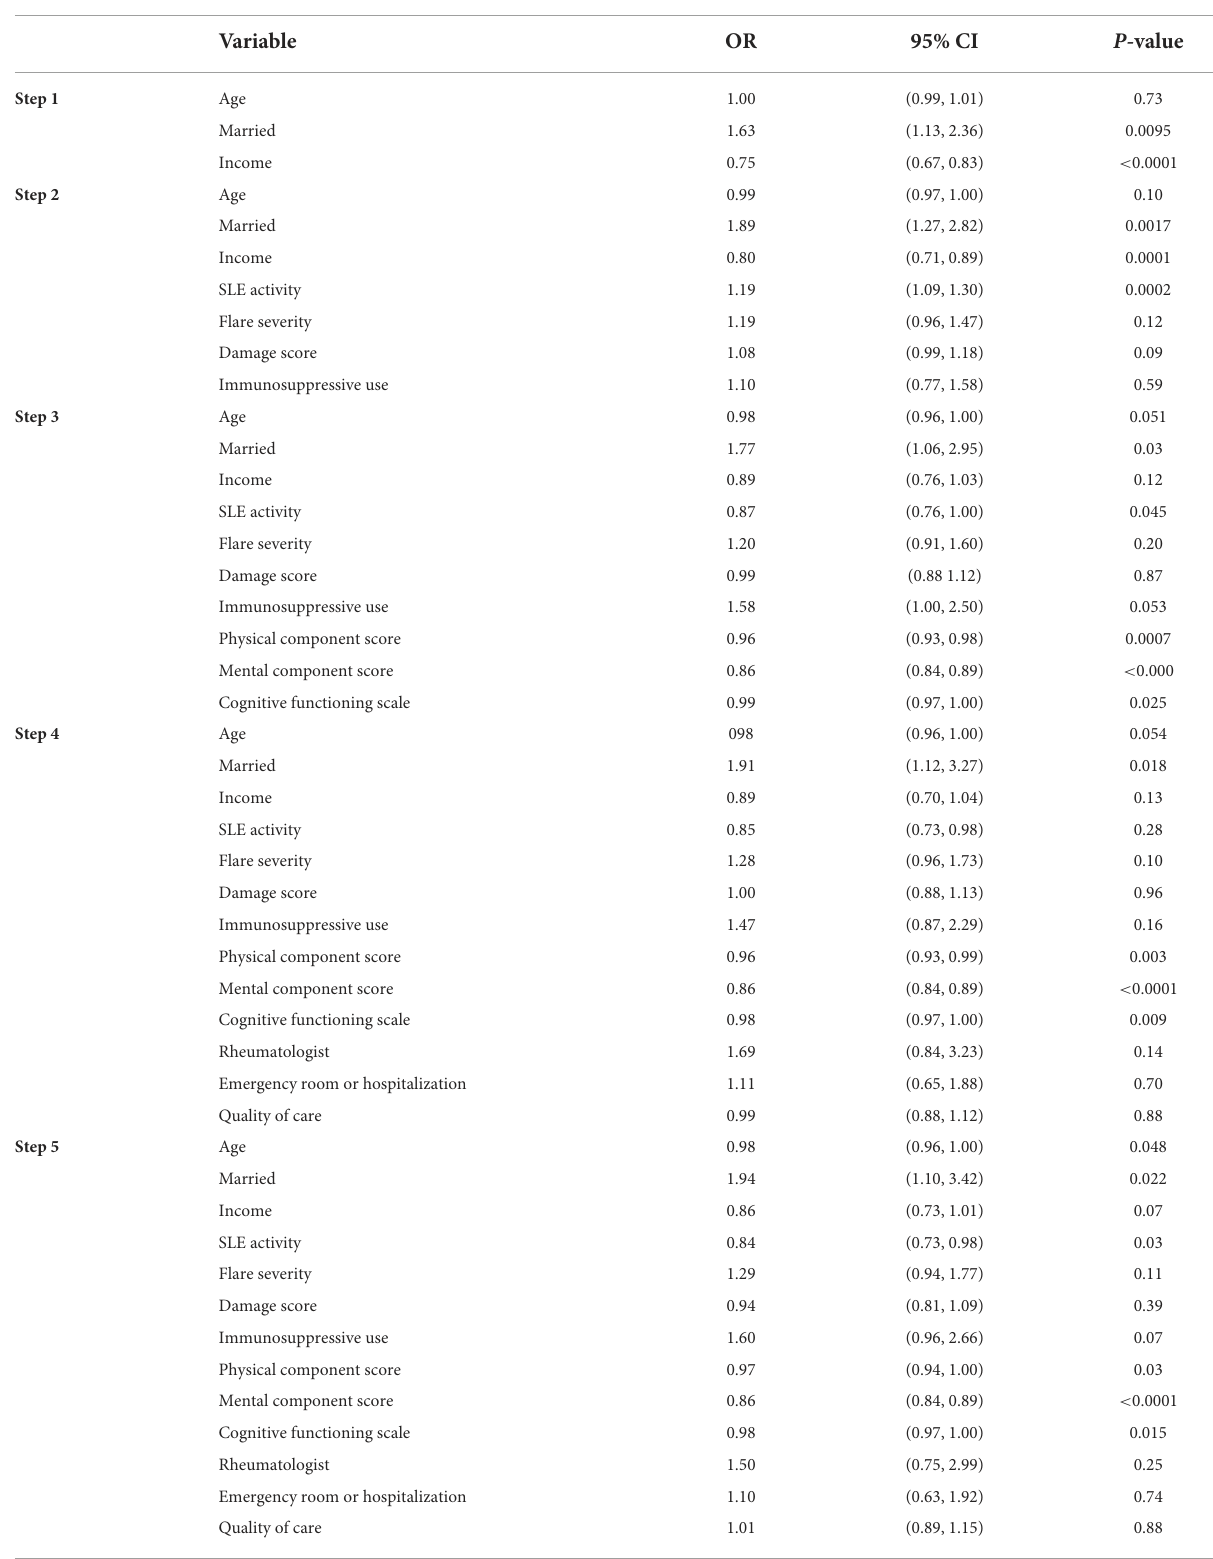
TABLE 3 Logistic regression models for high stress (PSS > 6) at Baseline (wave